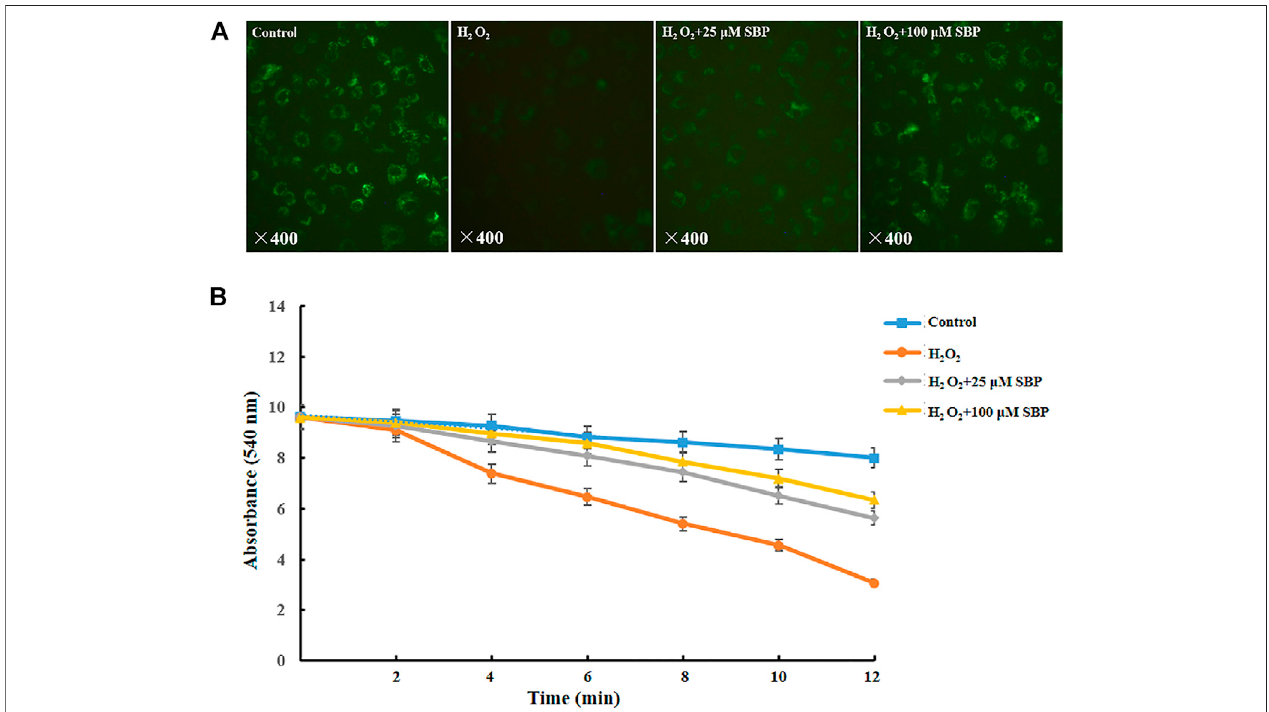
FIGURE3| Effects ofSBPonmorphologyofmitochondrialpermeabilityand swelling. (A) Mitochondrialpermeabilitytransitionpore ofRAW 264.7cells.Thegreen and red components of the images indicate calcein fl uorescence. (B) Mitochondrial swelling of RAW 264.7 cells.